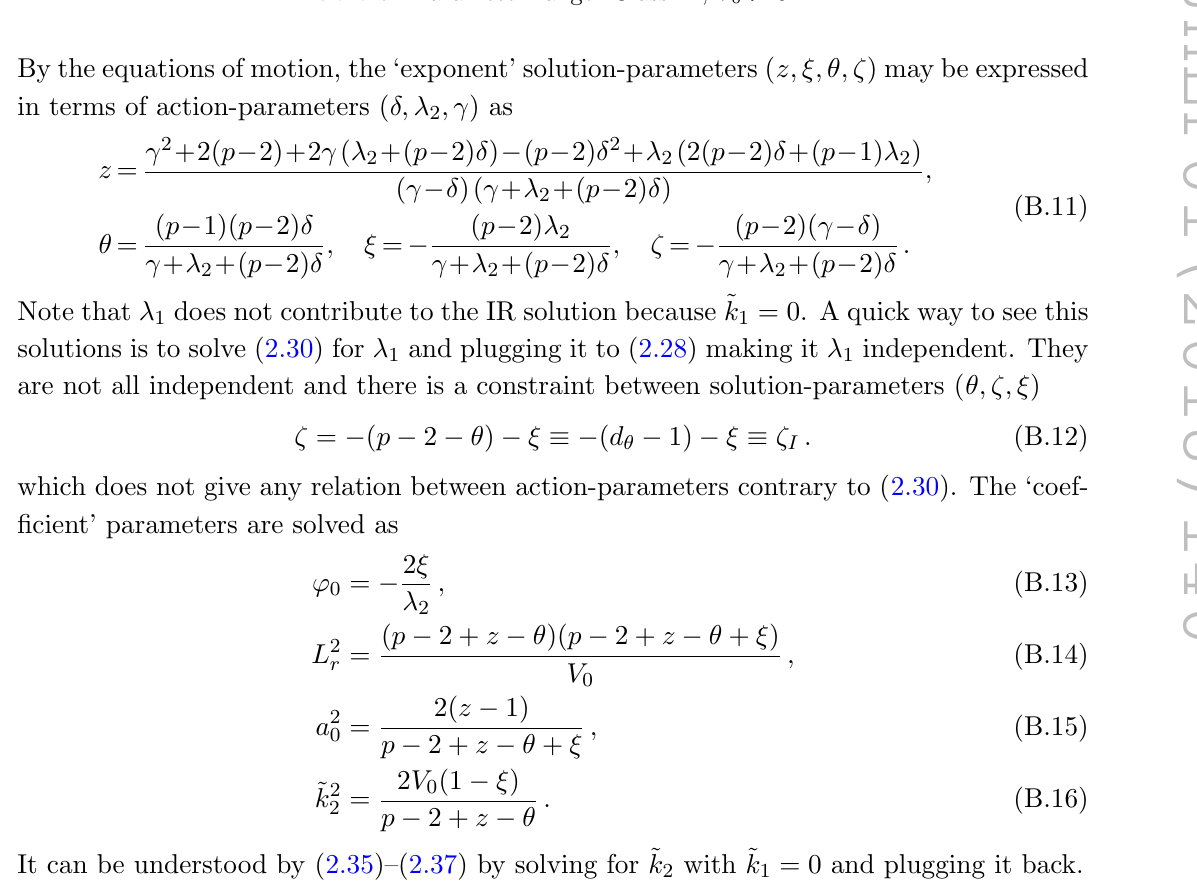
Table 7. Parameter range: Class I-i, V 0 >